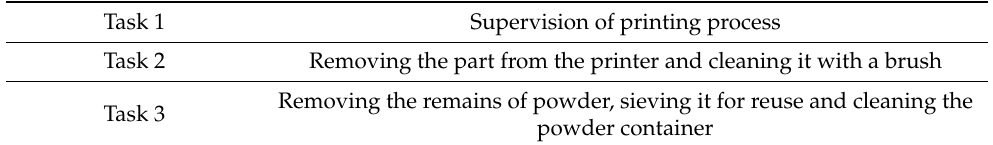
Table 1. Description of the tasks under